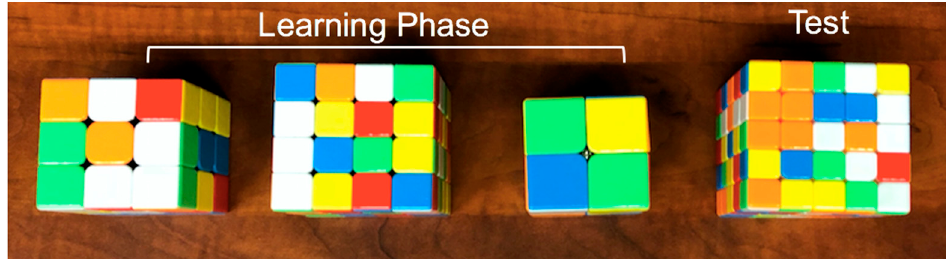
Figure 2. Progression-order condition. Cubes increase in size during the learning phase (2 × 2 × 2; 3 × 3 × 3; 4 × 4 × 4) before completing the test (5 × 5 × 5).